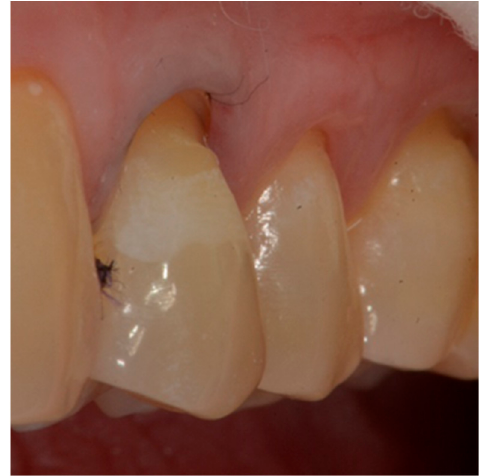
Figure 5. NCCL after etching.